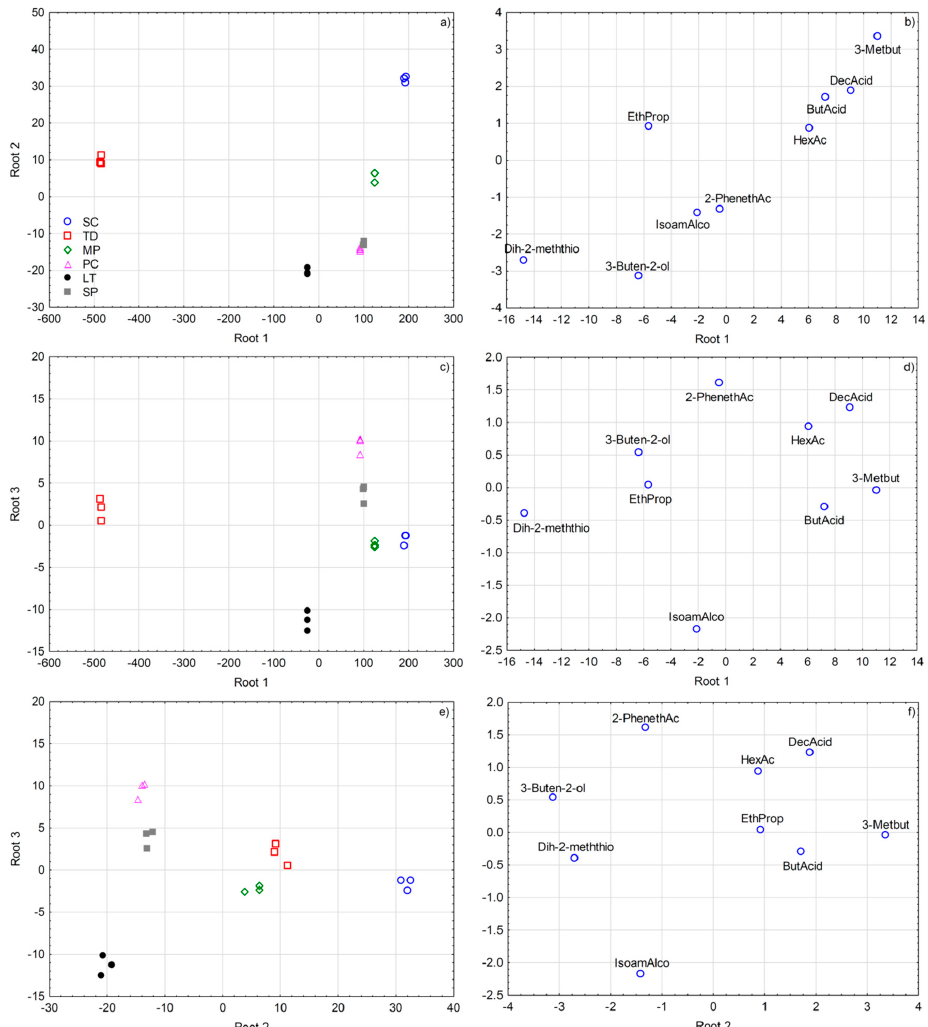
Figure 2. Separation of Malvazija istarska grape musts in early fermentation according to inoculated yeast species defined by the first three discriminant functions (roots) obtained by forward stepwise discriminant analysis on the basis of volatile aroma compound composition. Projection of grape must samples is shown in sub-figures a), c), and e), while standardized coefficients of the variables (volatile aroma compounds) are shown in sub-figures b), d), and f). Abbreviations: SC— Saccharo- myces cerevisiae ; TD— Torulaspora delbrueckii ; MP— Metschnikowia pulcherrima ; PC— Pichia kluyveri ; LT— Lachancea thermotolerans ; SP— Schizosaccharomyces pombe ; Dih-2-meththio—dihydro-2-methyl- 3(2H)-thiophenone; EthProp—ethyl propanoate; IsoamAlco—isoamyl alcohol; 2-PhenethAc—2- phenethyl acetate; HexAc—hexyl acetate; ButAcid—butanoic acid; DecAcid—decanoic acid; 3-Met- but—3-methylbutanal.